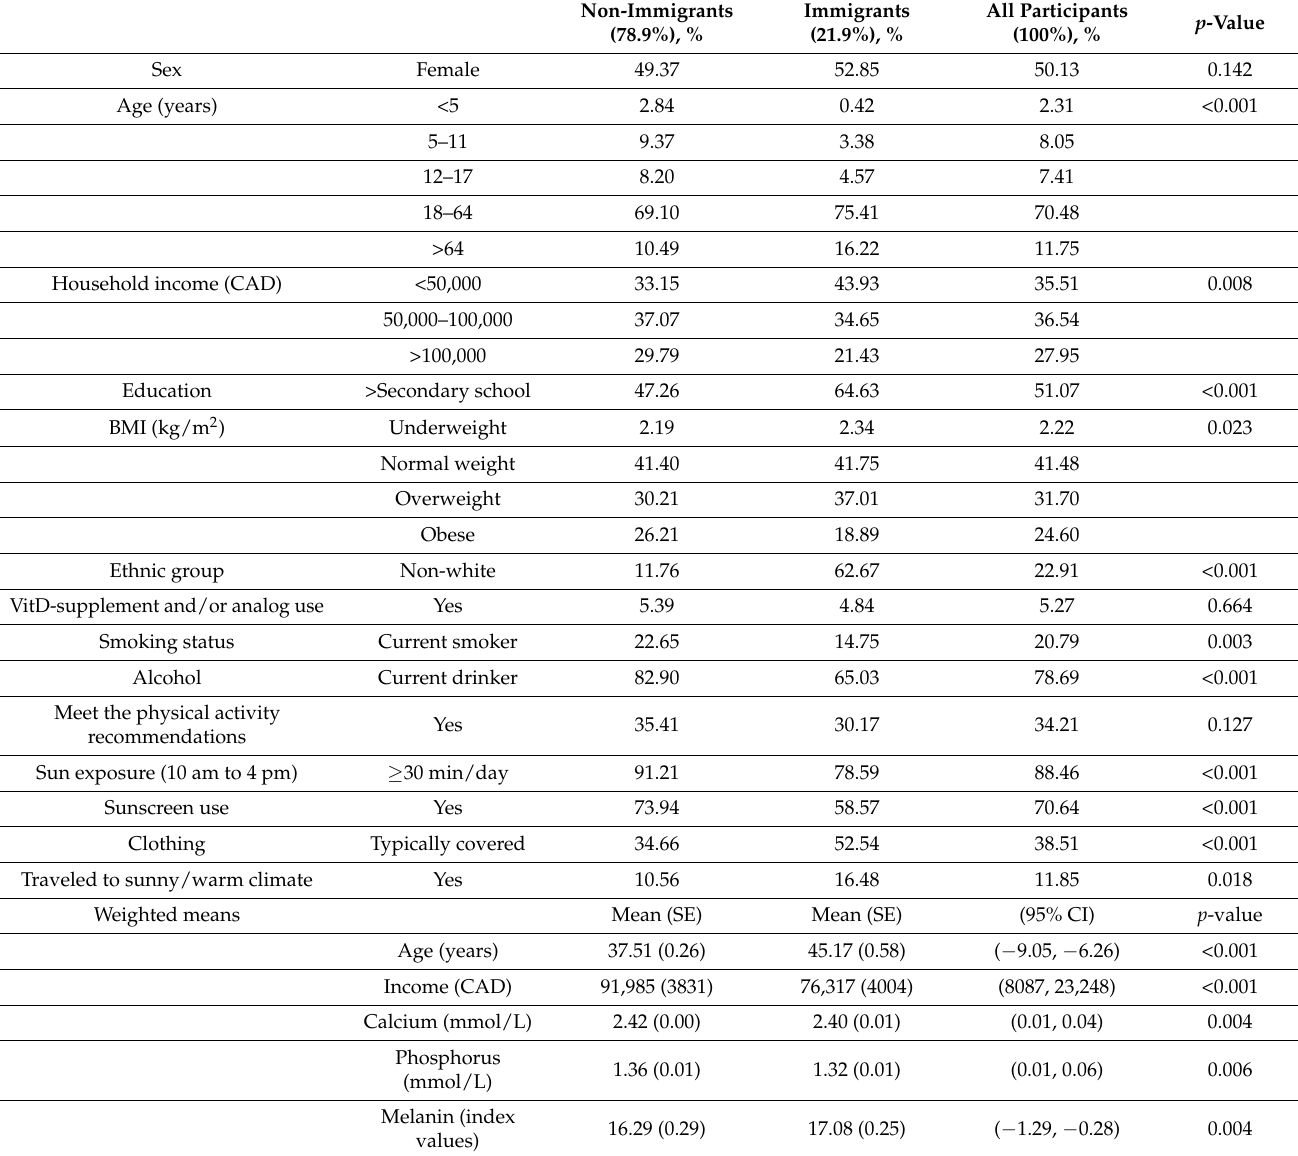
Table 1. Weighted prevalence of immigrants and non-immigrants by sociodemographic and lifestyle factors using Cycles 3 and 4 of Canadian Health Measures Survey